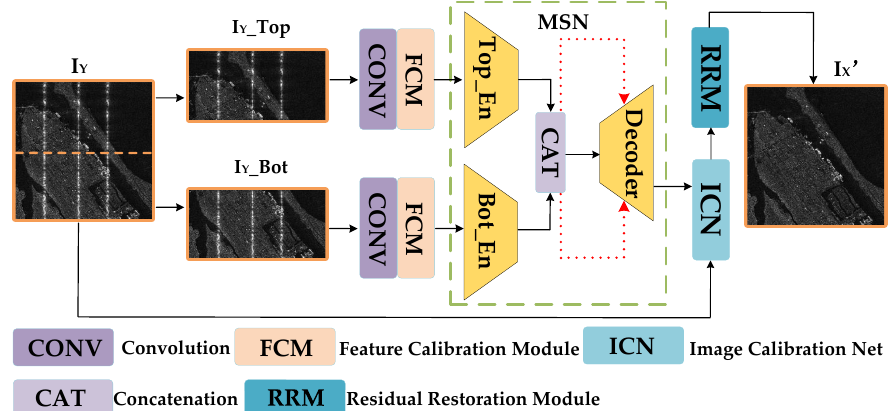
Figure 2. The overall structure of Multi-dimensional Calibration and Suppression Network, referred to as MCSNet. Where I Y and I X (cid:48) denote the input image with interference and the output result of MCSNet, respectively. The black arrows indicate the transfer information stream and the red dashed lines indicate the transfer feature stream. CONV and CAT denote convolution and concatenation operations, respectively.